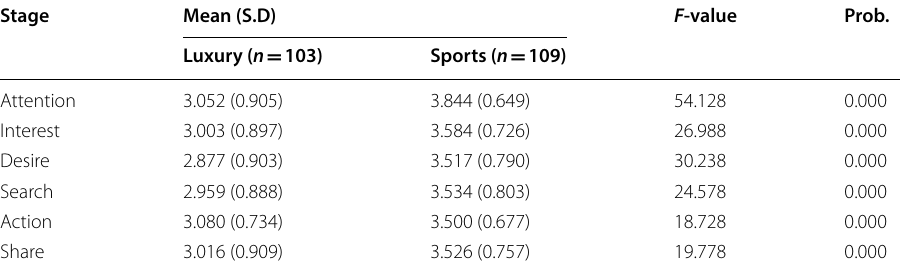
Table 4 Results of the one-way ANOVA analysis